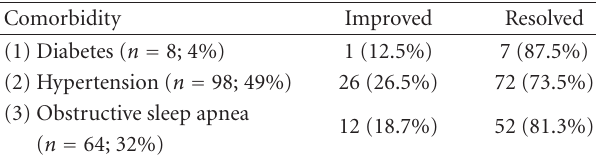
Table 1: Comorbidity